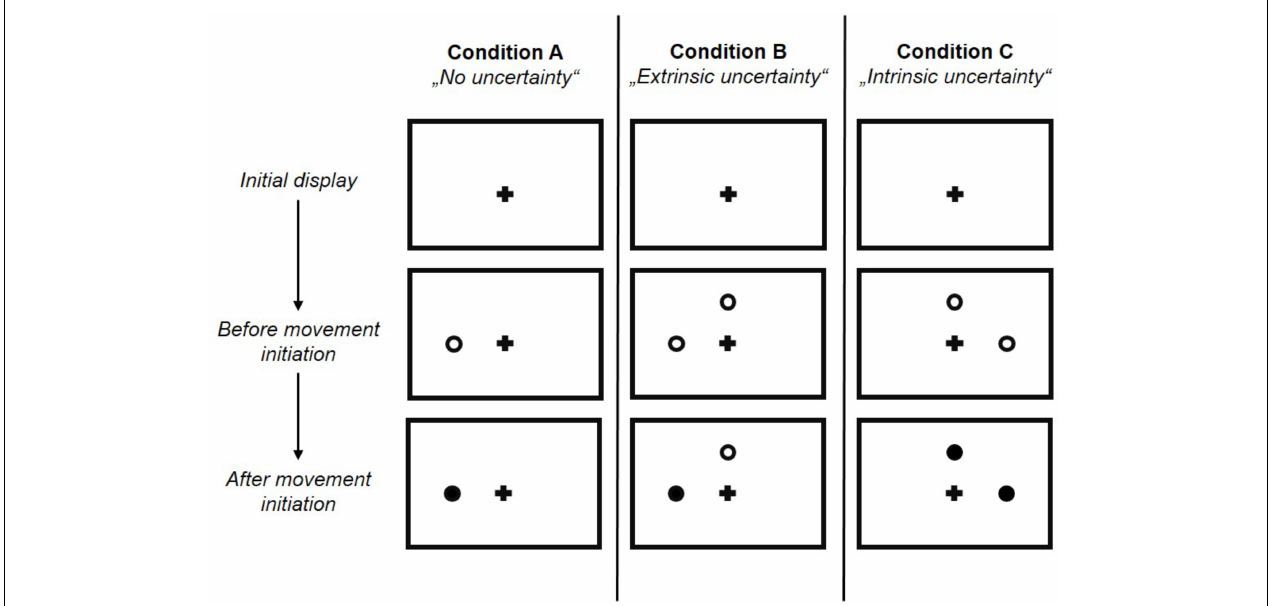
FIGURE 3 | Experimental conditions. Example target displays before and after movement initiation are depicted to highlight the differences between the three experimental conditions. Condition A and B were forced choice conditions with different levels of uncertainty with regard to the amount of available information about the final reach target before movement onset. Condition A (“no uncertainty”) was characterized by very low level of target uncertainty, while Condition B (“extrinsic uncertainty”) was characterized by high level of target uncertainty. In Condition C (“intrinsic uncertainty”) the source of uncertainty was manipulated, i.e., not originating from the limited amount of available target information as in Condition A and B, but from the ambiguity between potential reach targets. Please note that in each of the three experimental conditions, reach targets could be located at any of the three locations and this figure shows different example target locations for each